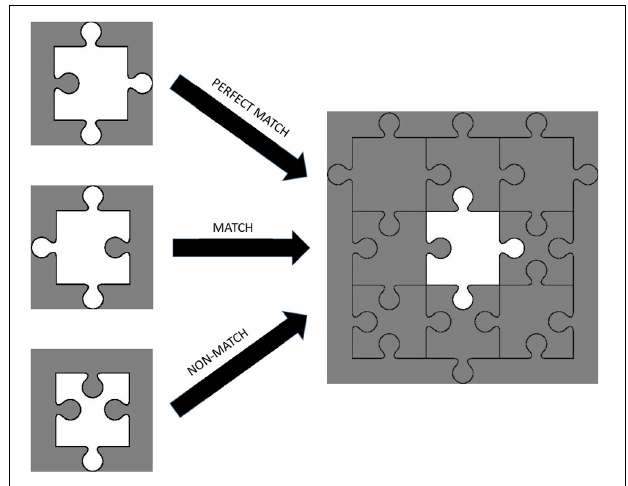
FIGURE 2 | Examples of perfect match, match, and non-match